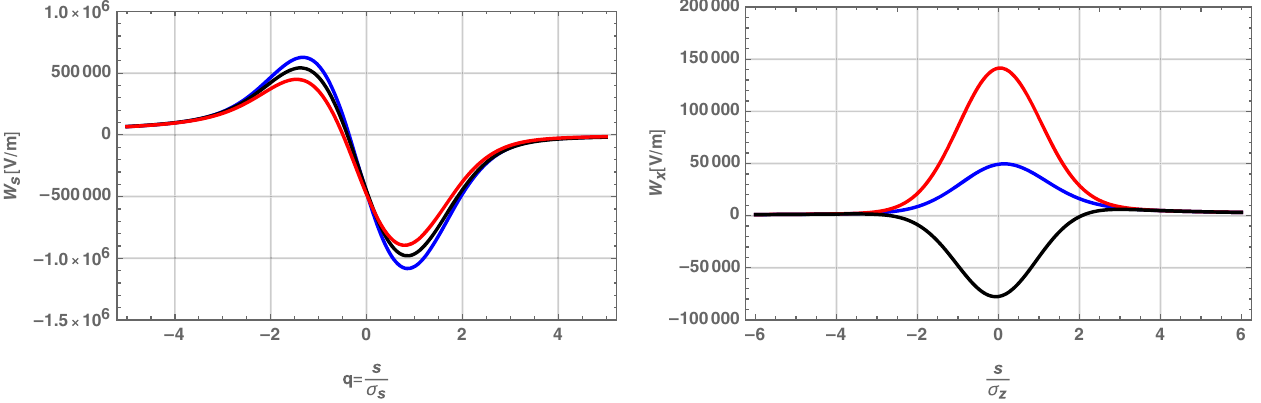
FIG. 12. Longitudinal (left) and horizontal (right) forces at various of horizontal offsets, δ x ¼ 2 . 5 σ (red), 0 (blue), − 2 . 5 σ (black), for a Gaussian bunch moving along a circle with radius, ρ ¼ 10 m at energy of γ ¼ 100